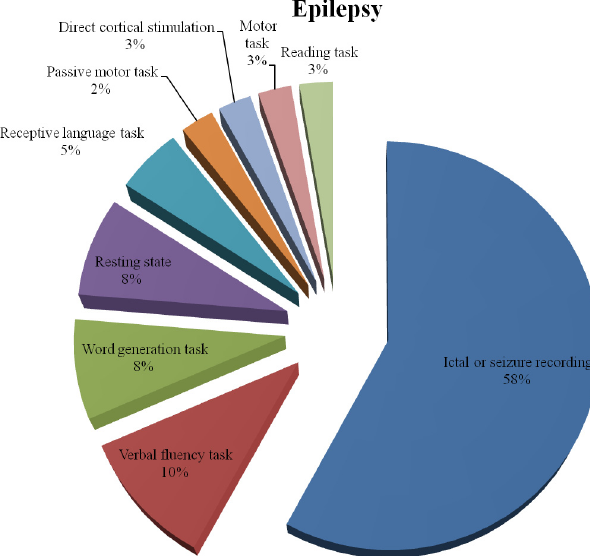
Fig. 3. Task-based distribution of studies on epilepsy (total studies: